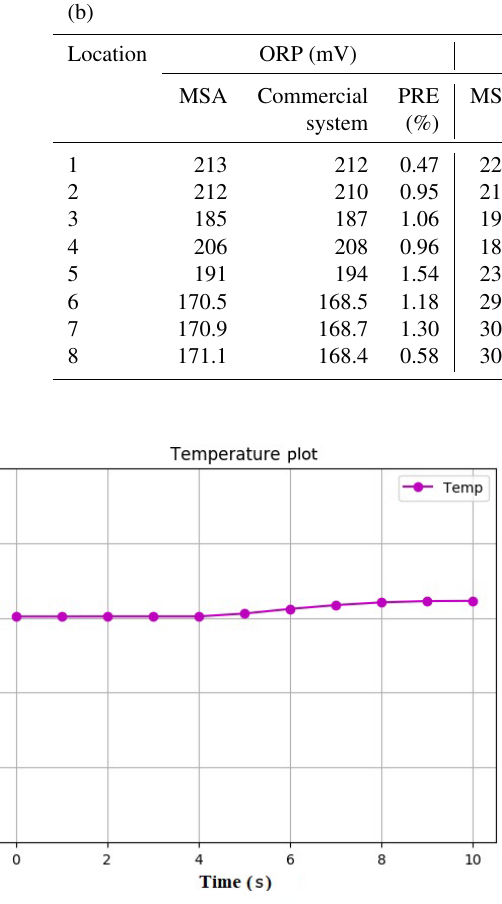
Figure 4. Temperature plot in GUI.